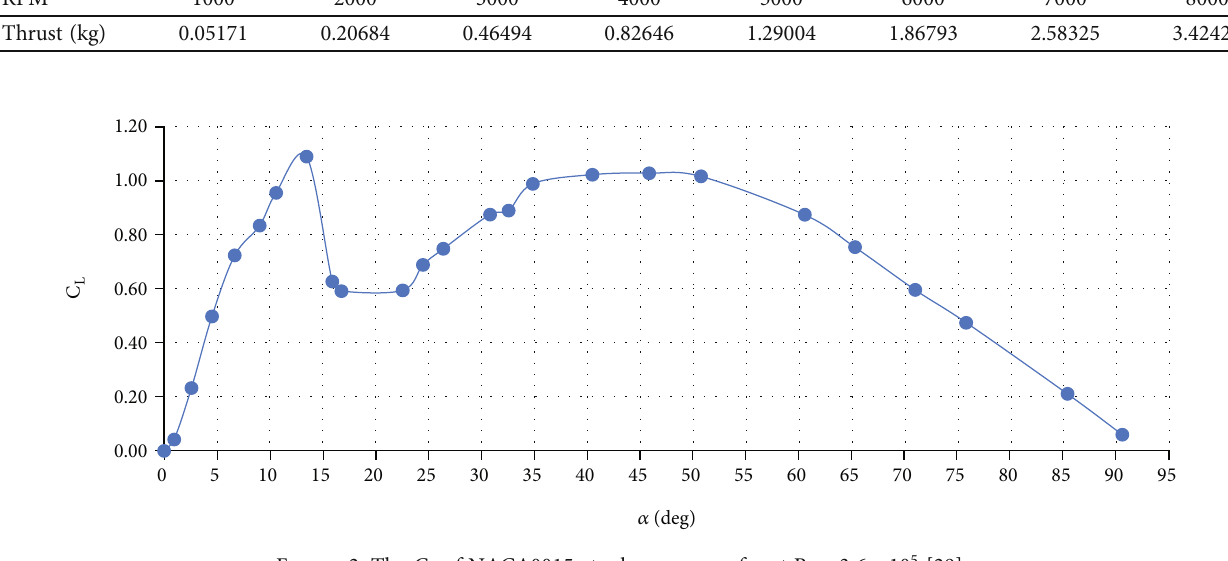
Figure 2: The C L of NACA0015 at a large range of